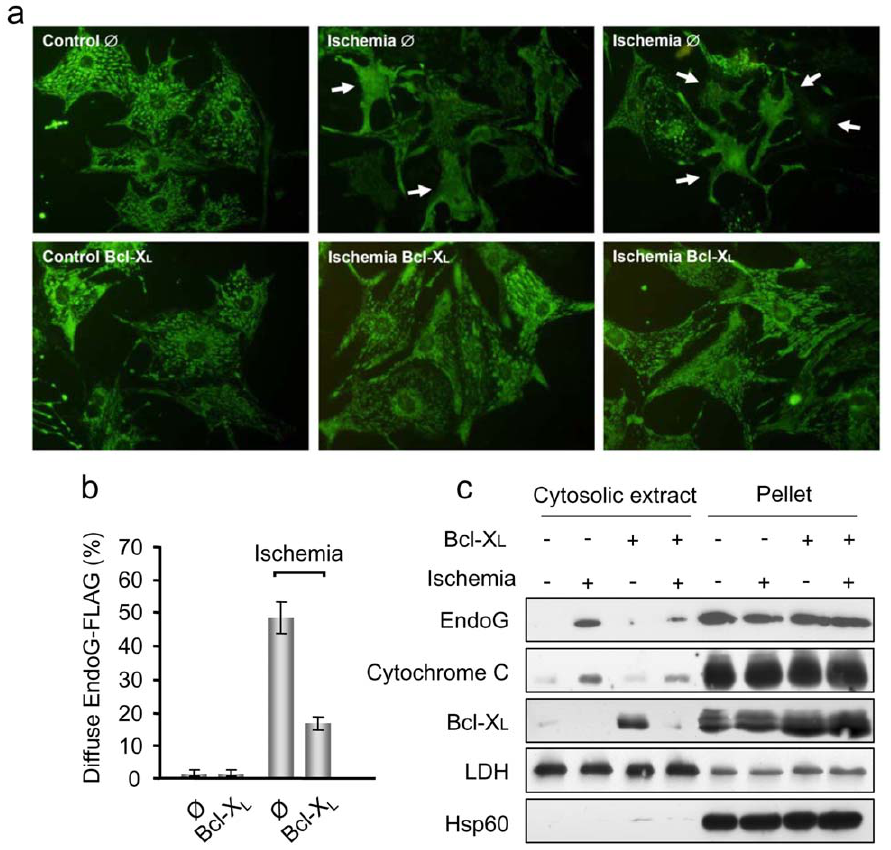
Figure 5. Bcl-x L blocks EndoG translocation in ischemic cardiomyocytes. a) Immunofluorescence of EndoG-FLAG in control and ischemic (6 hours) cardiomyocytes transduced previously with viruses inducing EndoG-FLAG overexpression and empty viral particles (Ø) or particles inducing Bcl-x L overexpression. Cells were fixed with paraformaldehyde. This procedure allows detection of EndoG-FLAG, even when it is released from mitochondria, but not the mitochondrial marker Hsp60 (see the results section and Supplementary Figure 3). b) Quantification of the experiments described in a). The graph shows the percentage of cardiomyocytes with diffuse pattern of the EndoG-FLAG staining in control and ischemic cultures of empty virus-transduced cells (Ø) and cells transduced with viruses for Bcl-x L overexpression (Bcl-x L ), counted in three independent experiments. Error bars are s.e.m. c) EndoG-FLAG release was assessed by Western Blot in cytosolic extracts from control cardiomyocytes (transduced with EndoG- FLAG and empty viruses) and cardiomyocytes overexpressing Bcl-x L (transduced with EndoG-FLAG and Bcl-x L viruses), in standard and ischemic conditions. Expression of Bcl-x L was assessed to confirm its increased expression in cardiomyocytes transduced with Bcl-x L . Lactate dehydrogenase (LDH) expression was checked as a cytosolic marker and Hsp60 expression was assessed as a mitochondrial membrane marker. The image